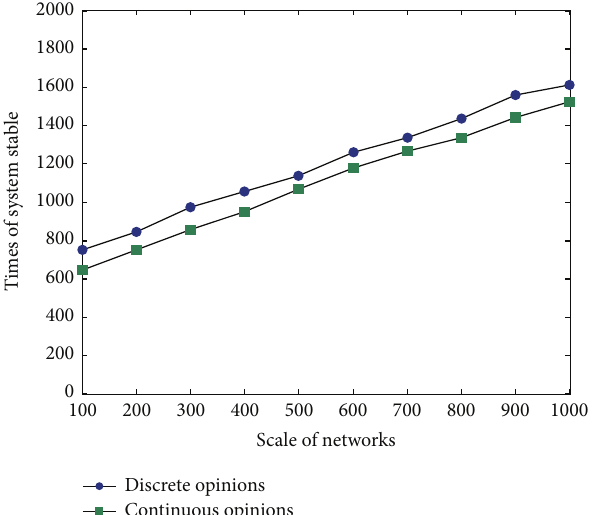
Figure 8: Times of system stable under different scale of networks for discrete opinions and continuous opinions. Each data point is an average over 30 independent experiments.